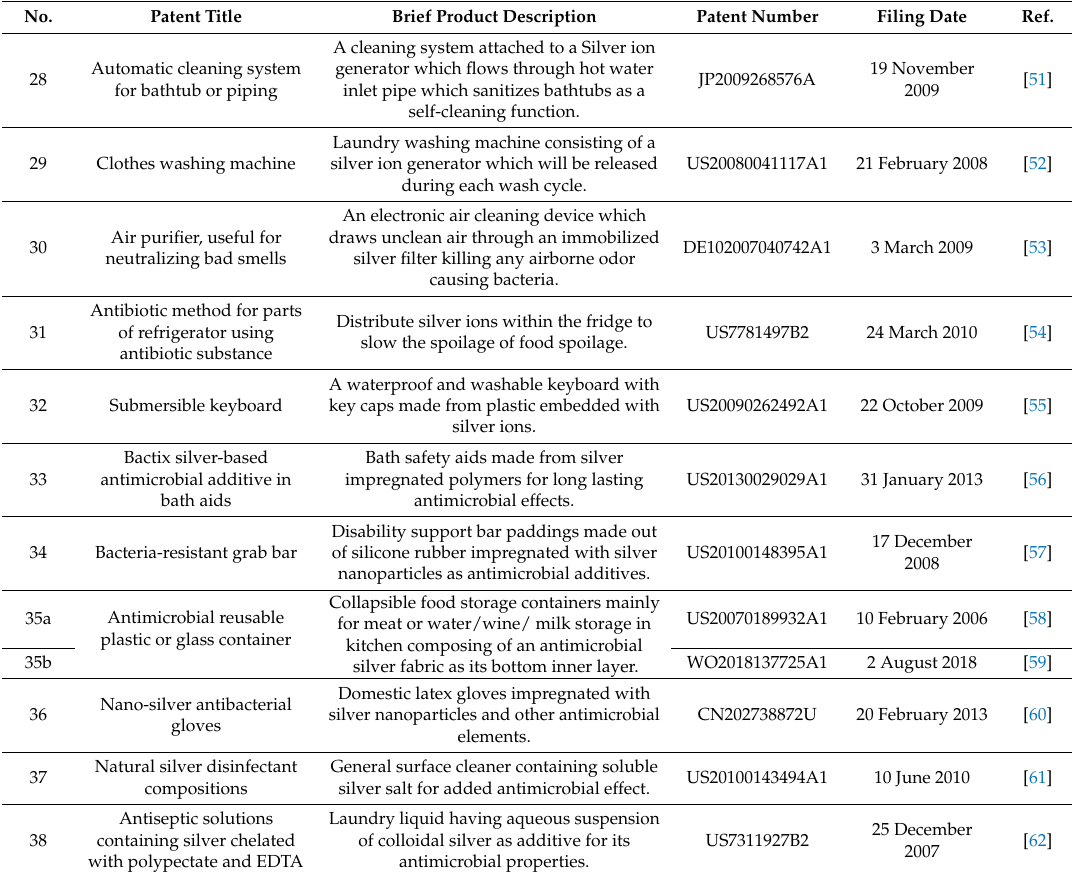
Table 3. List of patented home-use products containing silver as an antimicrobial